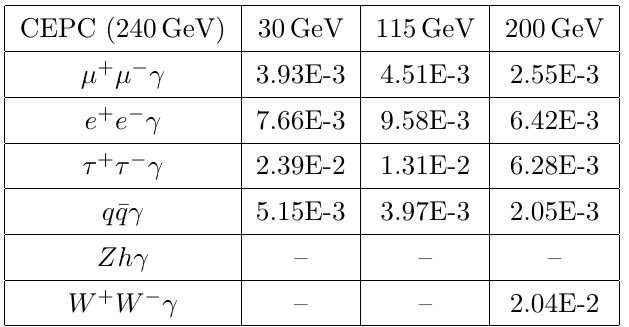
p B = 2 for m A 0 = 30 GeV, 115 GeV and 200 GeV in